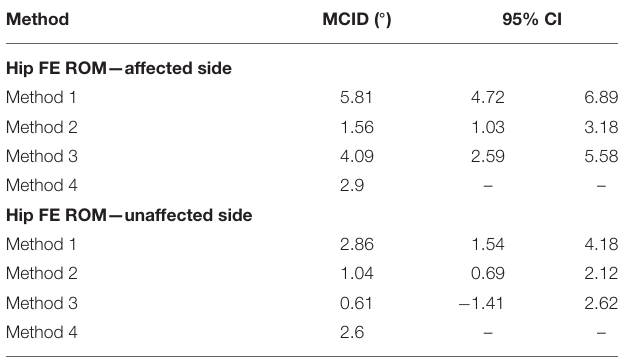
TABLE 2 | The mean hip FE ROM for the affected side and the unaffected side in the MCID group and no-change group.